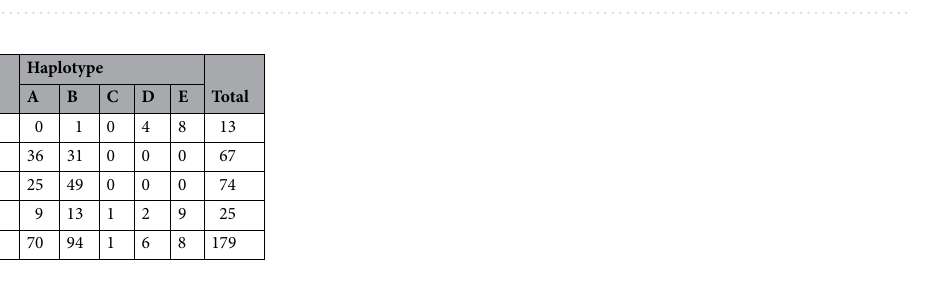
Table 5. The correspondence of clusters and haplotypes for raccoons in Chiba prefecture, Japan. The numerals are the number of individuals.